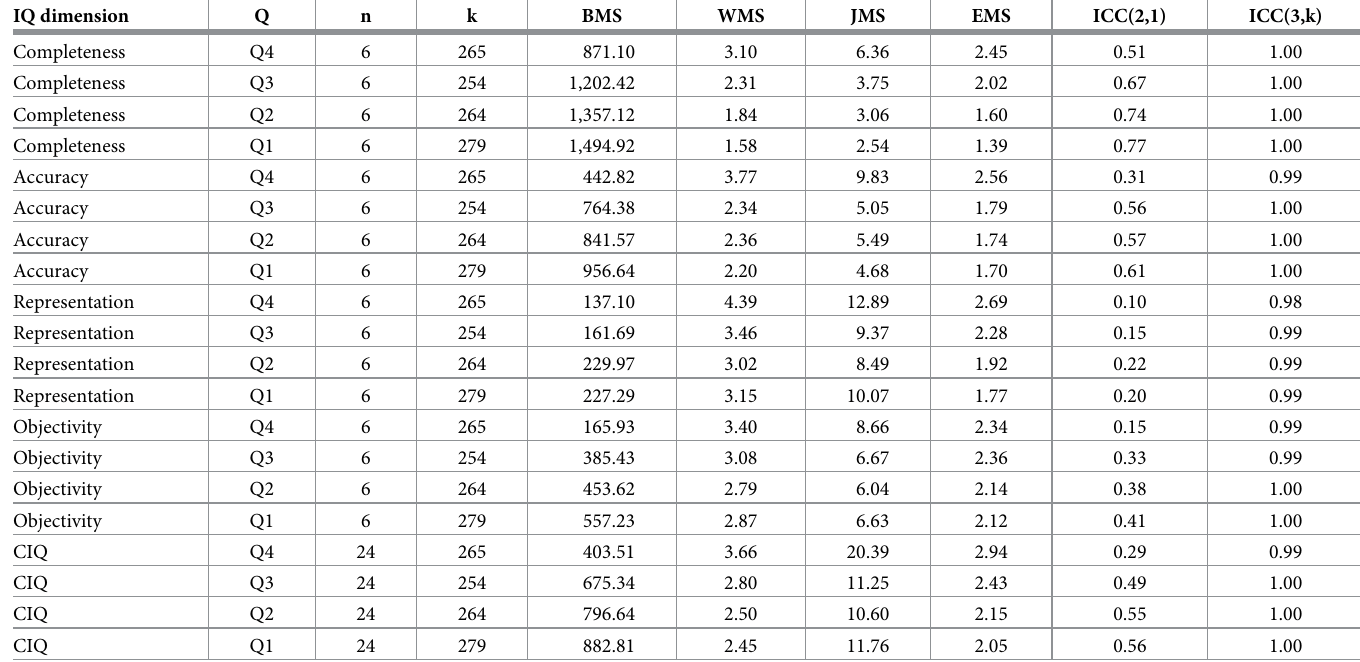
Table 1. ICC results in our